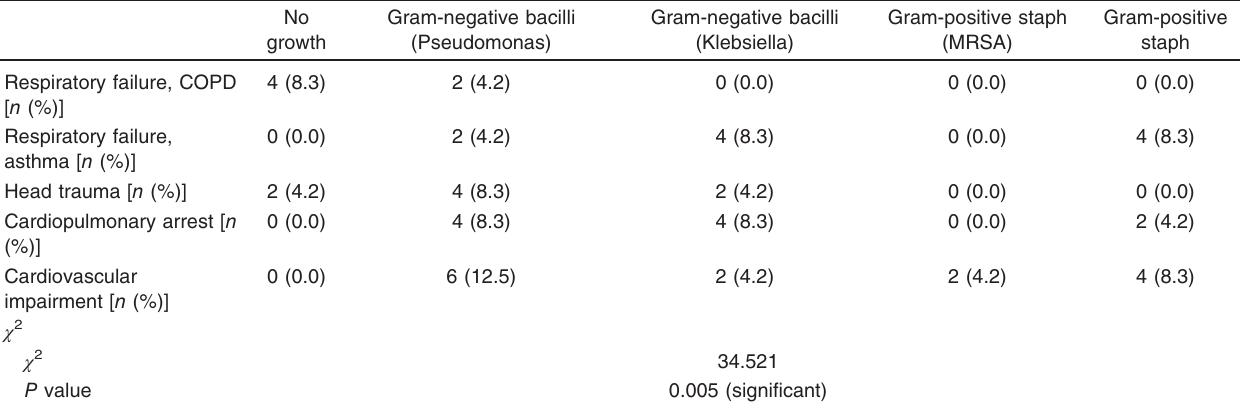
Table 10 Causes of mechanical ventilation in relation to the organism causing ventilator-associated pneumonia